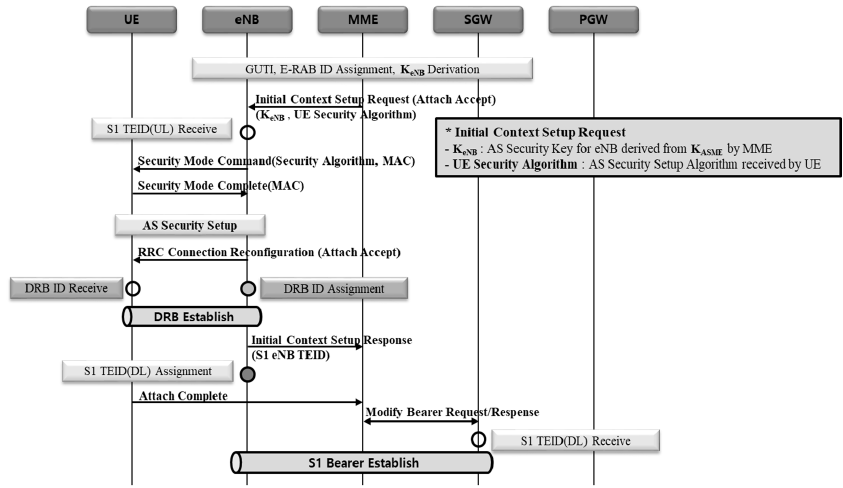
Sensors 2021 , 21 , x FOR PEER REVIEW Figure 5. eNB DRB and S1 GTP-U tunnel creation. Figure 5. eNB DRB and S1 GTP-U tunnel creation.